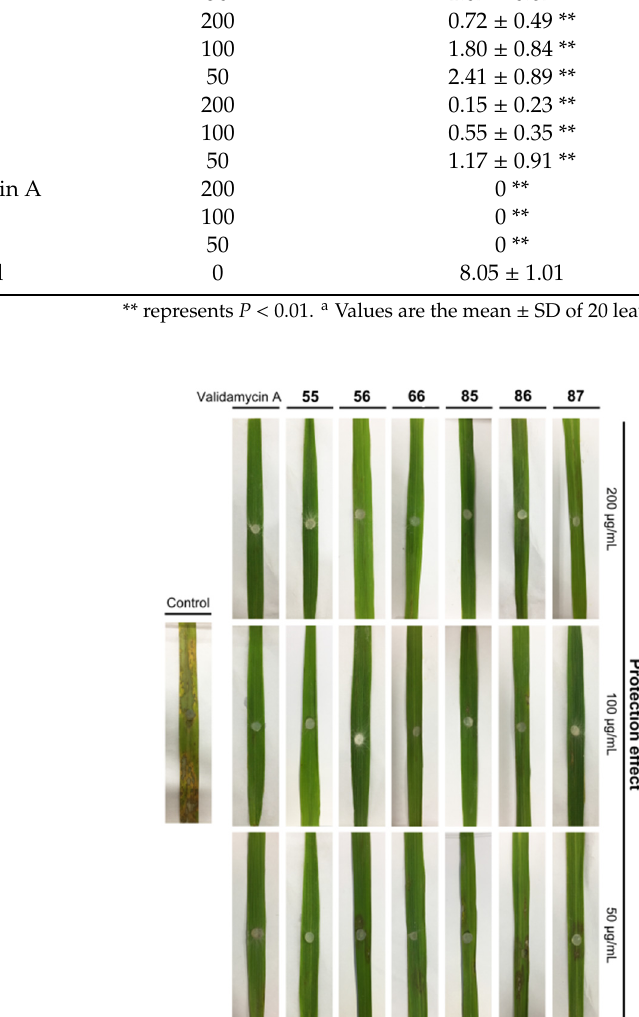
Figure 3. In vivo protective effect of selected compounds against R. solani using detached leaf assay.